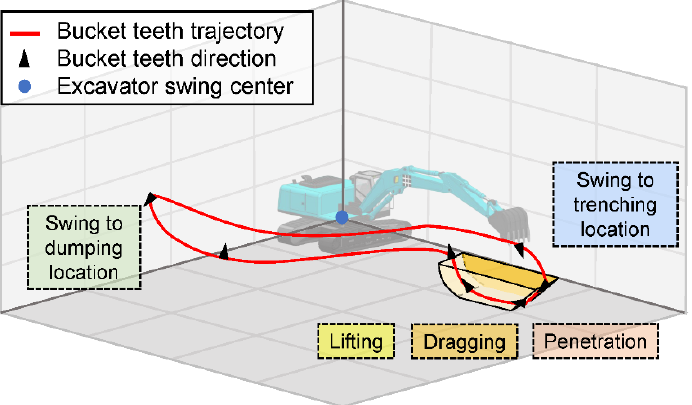
Figure 4. Illustration of bucket teeth path (red solid line). The black arrows represent bucket teeth orientation. The yellow trapezoid represents the trench. The blue solid dot represents the excavator swing center. The dashed rectangular blocks represent the five excavation